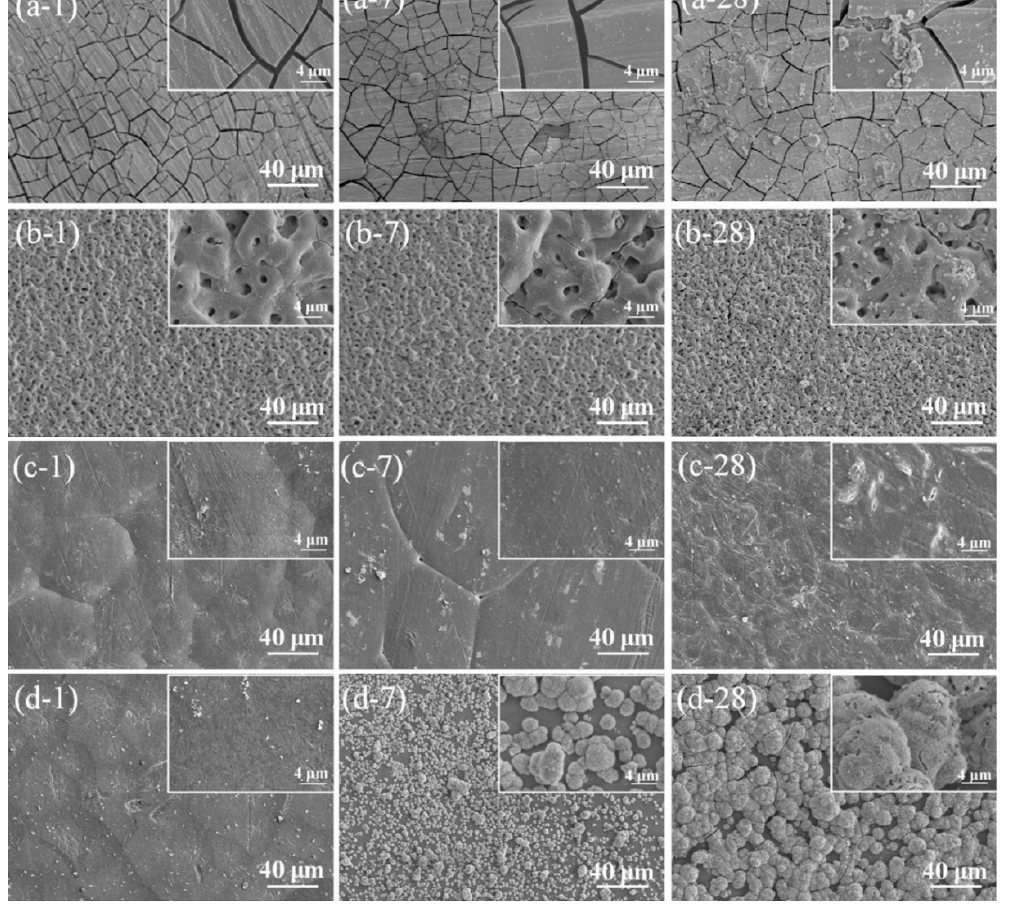
Figure 10. Degraded Mg-1.2Zn-0.5Ca alloy coupons aged at different durations after in vitro